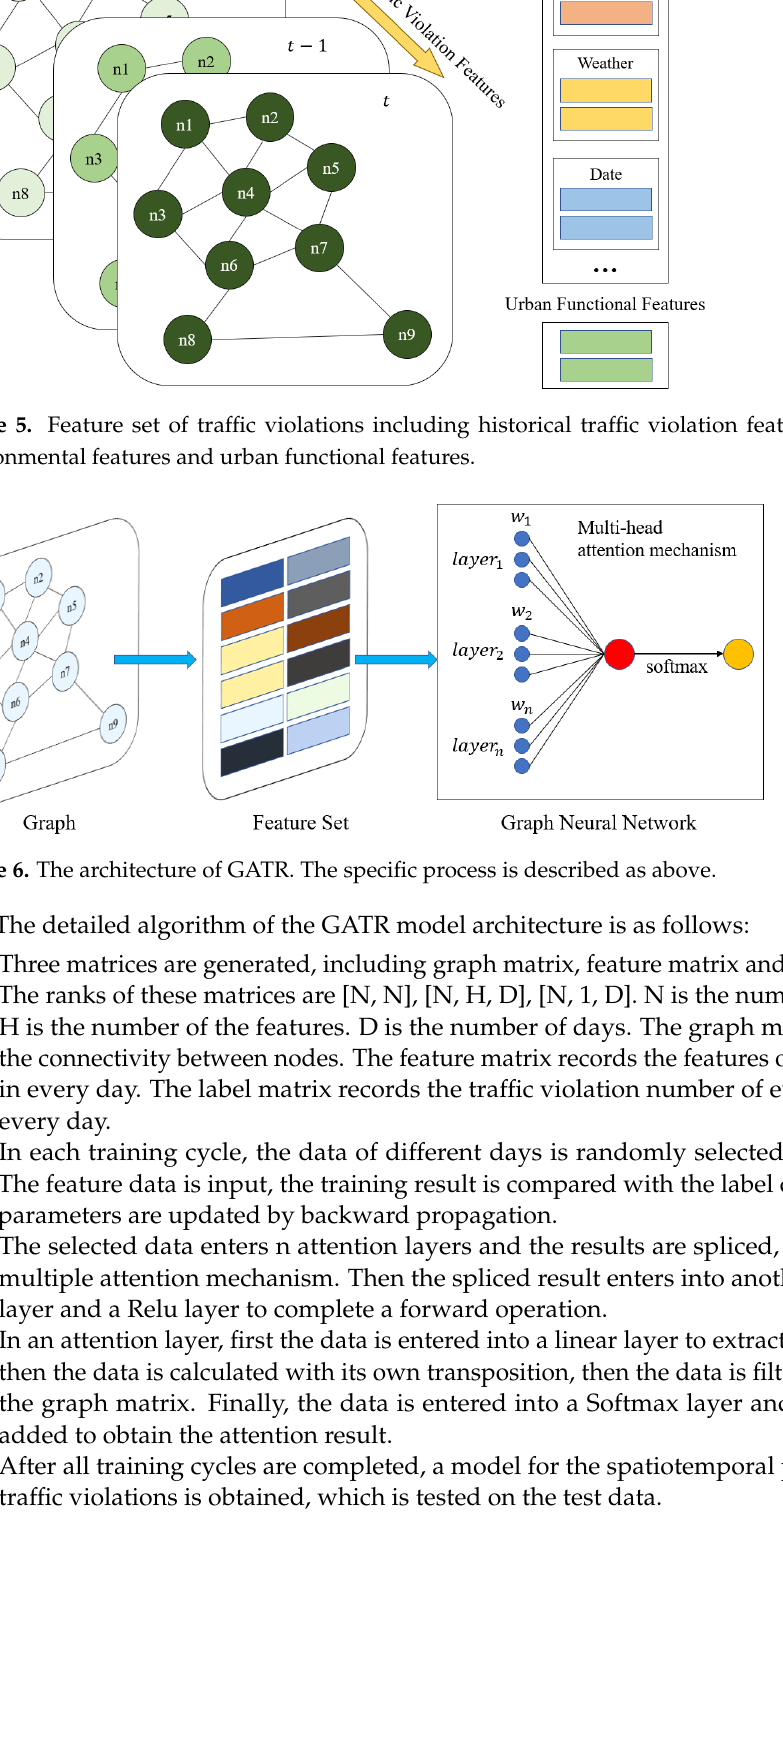
predicted target value of every node.